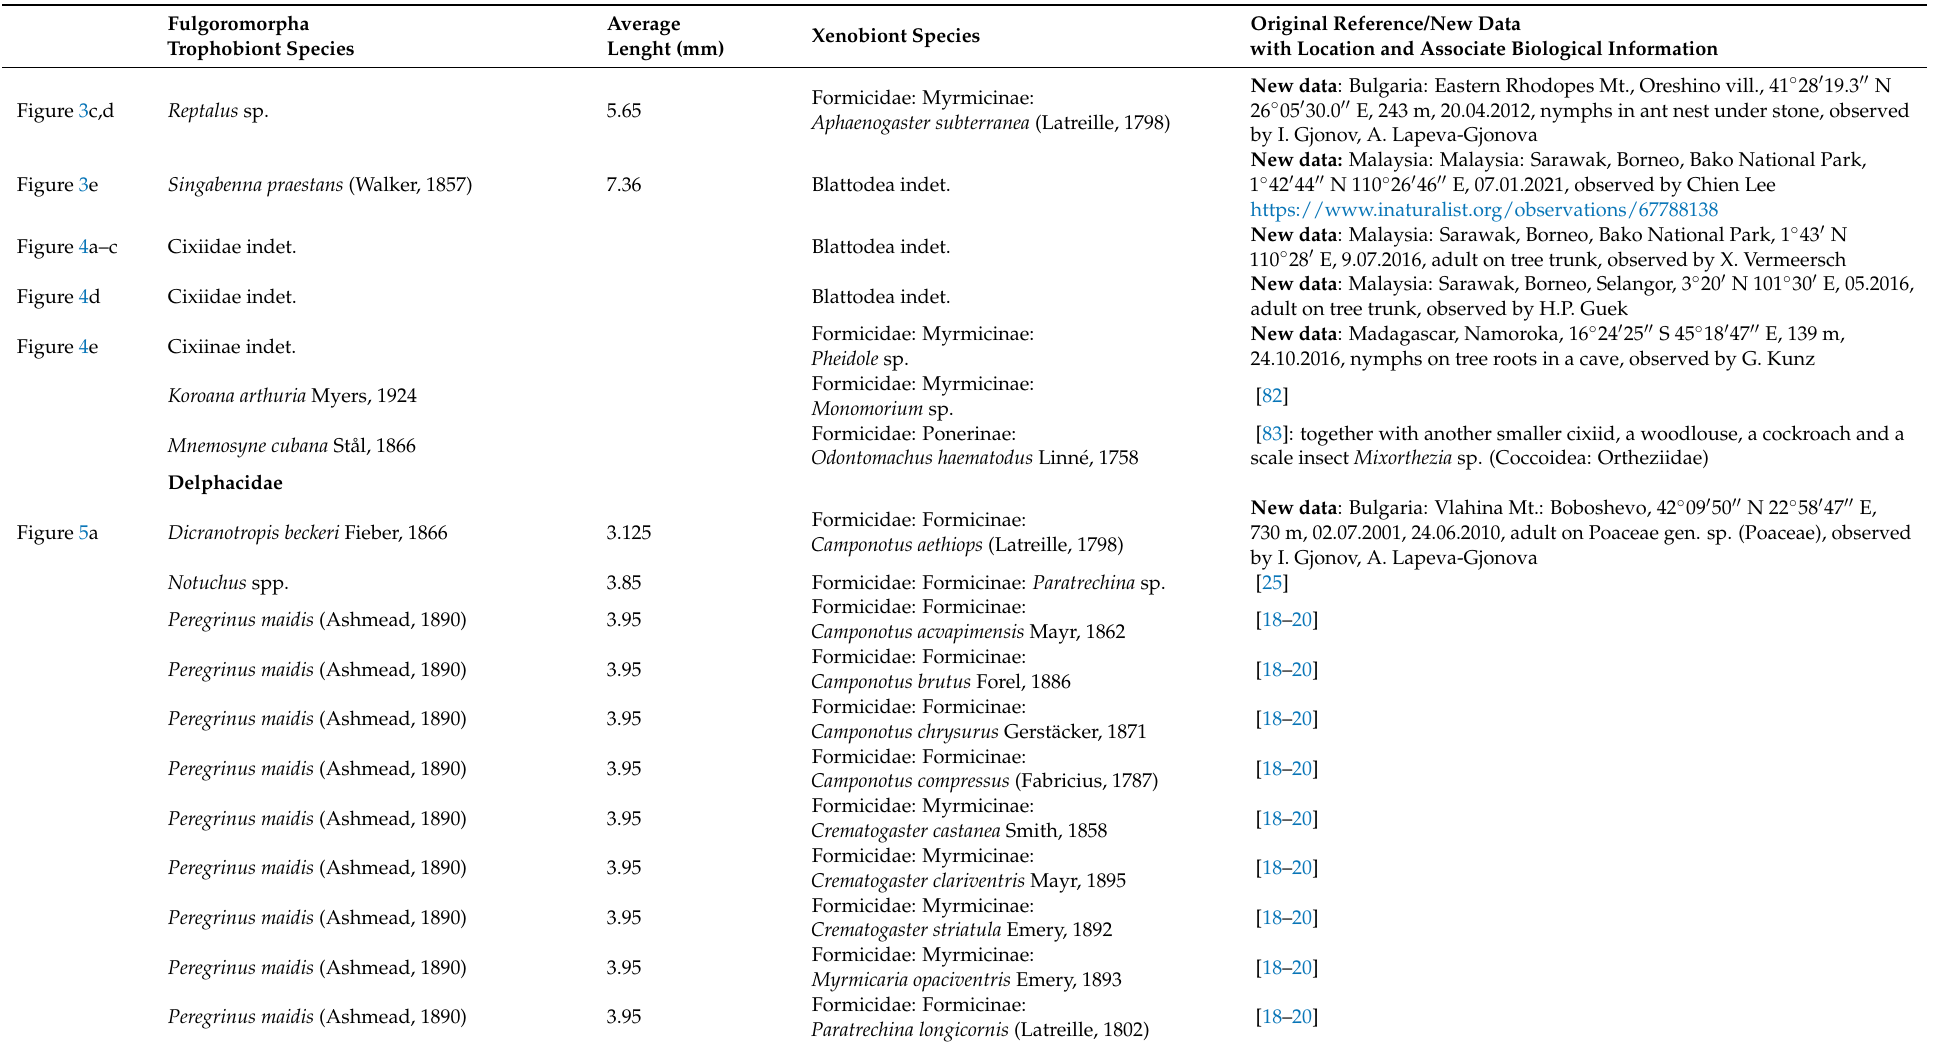
Figure 3c,d Reptalus sp. 5.65